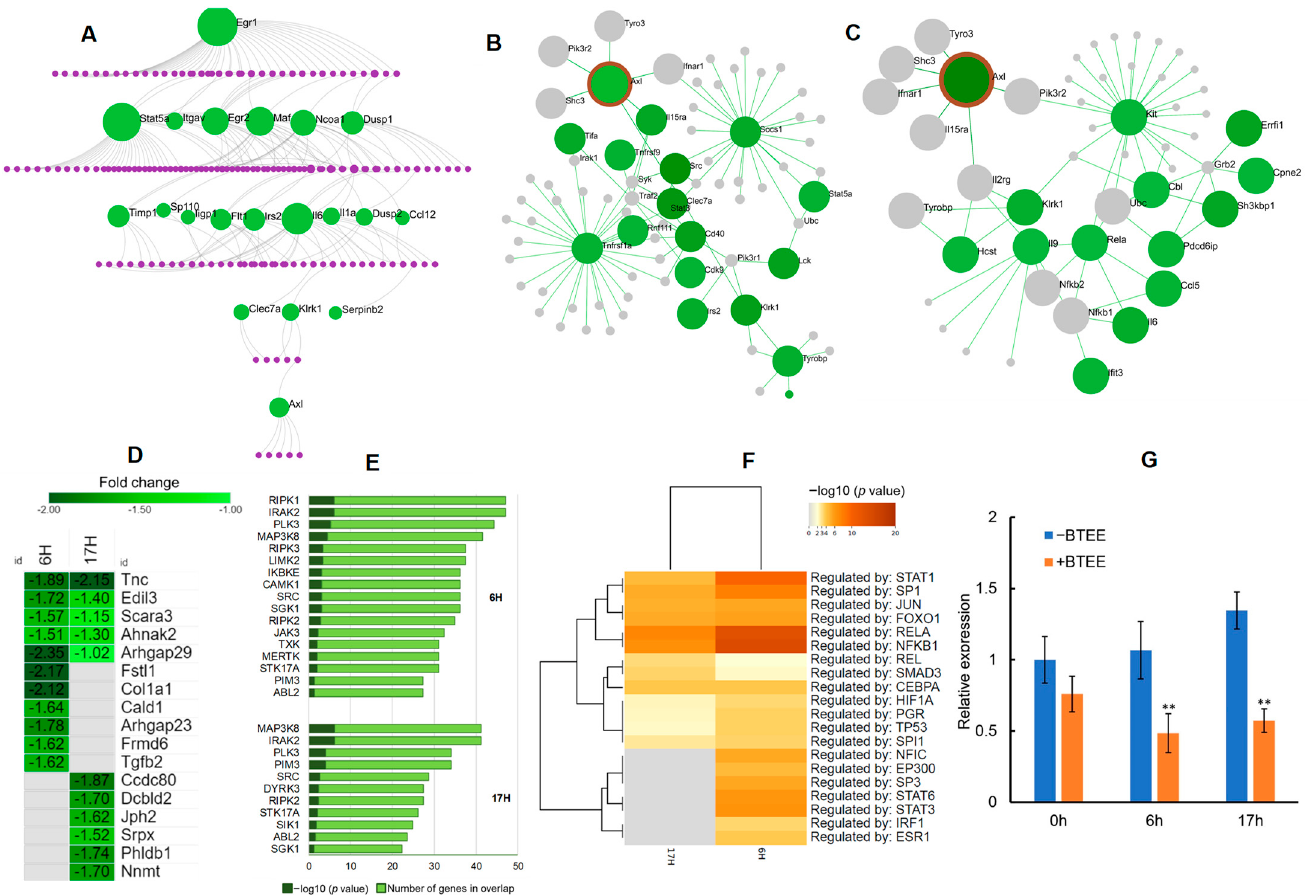
Figure 9. PPI interaction network and enrichment analysis. ( A ) Generic first-order PPI network by the commonly downregulated DEGs ( n = 66) in both 6-h and 17-h conditions shown in the ‘Sugiyama’ layout. Each green node represents the seed proteins and edges indicating known interactions (InnateDB Interactome database) between two connecting proteins. Purple nodes represent nonsignificant genes. Node neighborhood analyses showing expression profile of highly interacting genes with Axl in ( B ) BTEE + LPS vs. LPS 6-h condition and ( C ) BTEE + LPS vs. LPS 17-h condition. ( D ) Heatmap showing expression profile of downregulated DEGs that coexpress with Axl . Coexpressed genes, ranked among the top 100, were identified with ARCHS4 gene–gene coexpression database. ( E ) Bar graph showing kinase enrichment analysis of the downregulated DEGs (ARCHS4 kinases coexpression database. ( F ) Heatmap showing TF enrichment analysis (TRRUST database). ( G ) Quantified PCR analysis data of Axl . ** p < 0.01 signi fi cance compared to control samples.